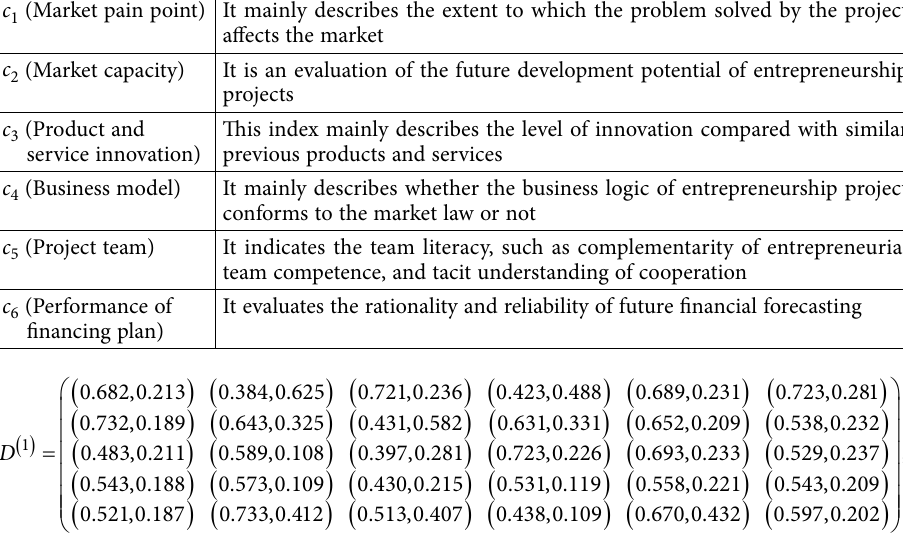
Table 5. Criteria for investment projects